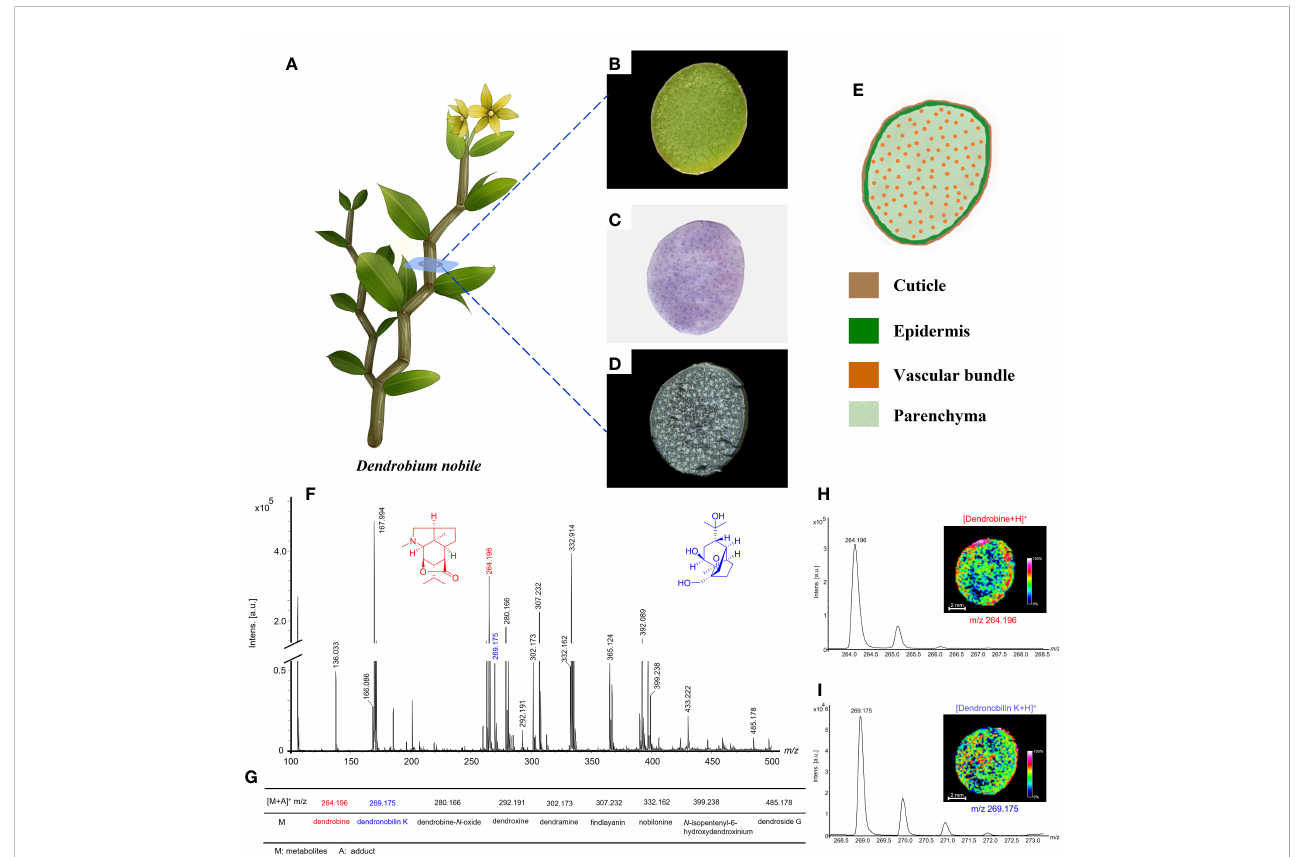
FIGURE 3 Morphology of Dendrobium nobile and MALDI-MS results based on optimized conditions. (A) Morphology of the plant; (B) Cross-section image of D nobile stem; (C) H&E stain image; (D) Frozen section; (E) The schematic image of cross-sections of D nobile stem showed the location of different tissues; (F) MALDI-MS results from the optimized frozen section of D nobile stem in positive-ion mode using 2-MBT as a matrix; (G) Table display of part of detected alkaloids and sesquiterpenes; (H) Dendrobine was used to show the optimized conditions suitable for alkaloids detection; (I) Dendronobilin K was used to show the optimized conditions suitable for sesquiterpenes